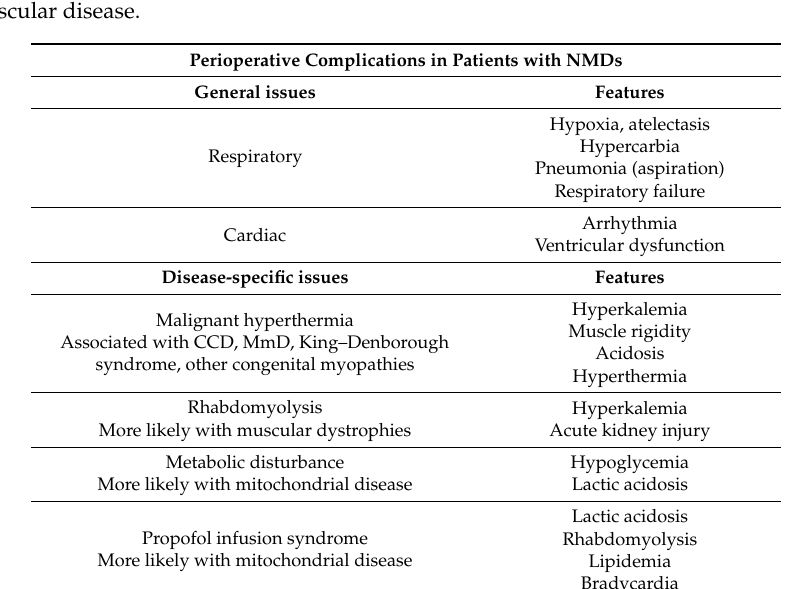
Table 3. Features of general and disease-specific perioperative complications for patients with neuromuscular